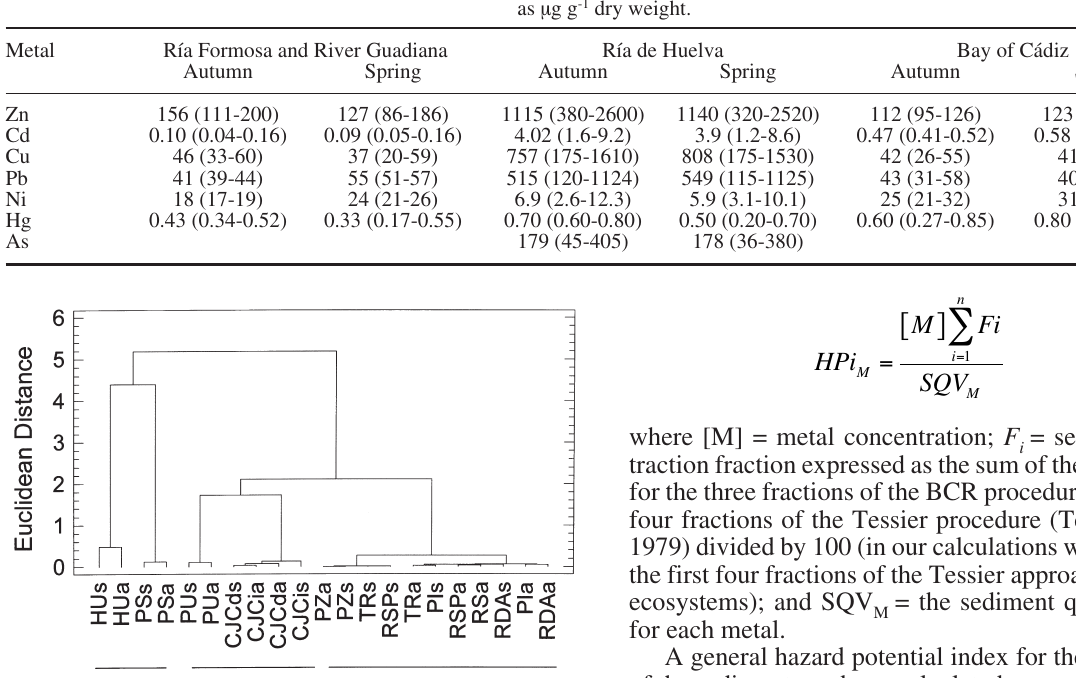
Table 2. – Average concentration of Zn, Cd, Cu and Pb in the Ría de Huelva (RHU) and the Bay of Cadiz (BC) and HPi Fi ) of the Tessier approach (Sáenz et al ., 2002) and SQVs (Choueri et al ., 2009). The HPi sum of the first four fractions ( ∑ n i =1 the range using SQVs corresponding to values for not polluted and highly polluted. Metal